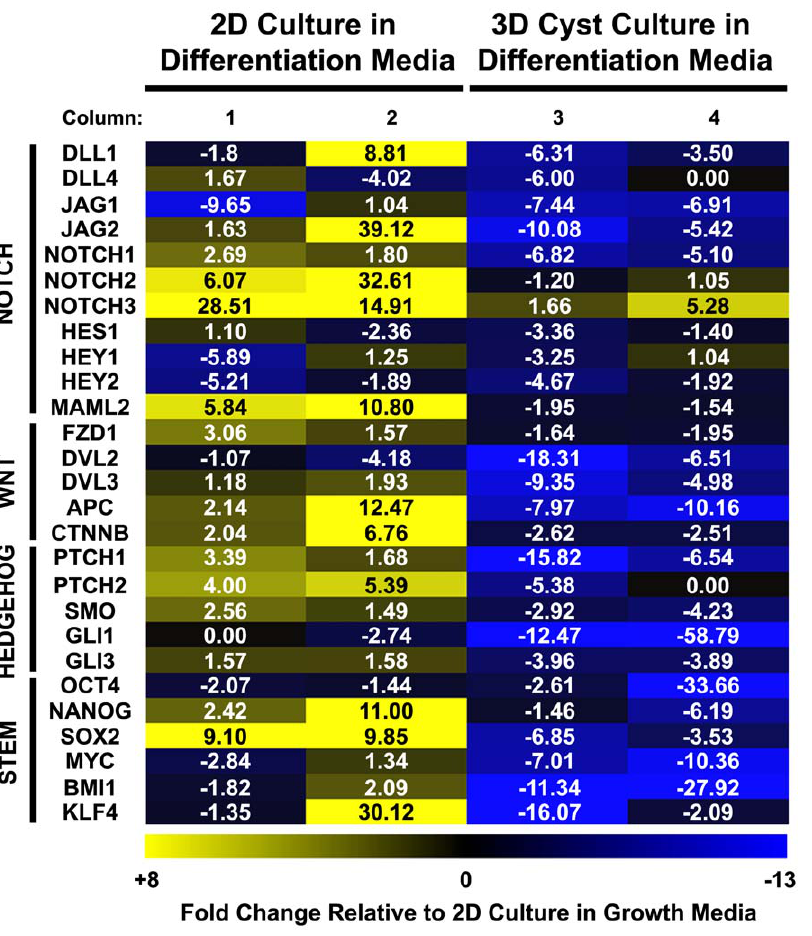
Figure 2. HBEC3 KT Cells Differentially Regulate Genes Associated with Progenitor Maintenance. Quantitative RT-PCR analysis of several genes within pathways critical for progenitor cell maintenance in HBEC3 KT cells five days after varying culture conditions. Transition of HBEC3 KT cells from standard growth media to differentiation media while cultured in 2D results in the significant upregulation of many genes within progenitor-associated pathways (Columns 1 and 2) relative to HBEC3 KT cells cultured within Matrigel TM with differentiation media and IMR90 fibroblast growth stimulus (Columns 3 and 4) ( P =0.00185). Results are from two independent experiments (Columns 1 and 3 and 2 and 4, respectively). Experimental samples normalized to gene expression in HBEC3 KT cells coincidentally maintained in growth media.